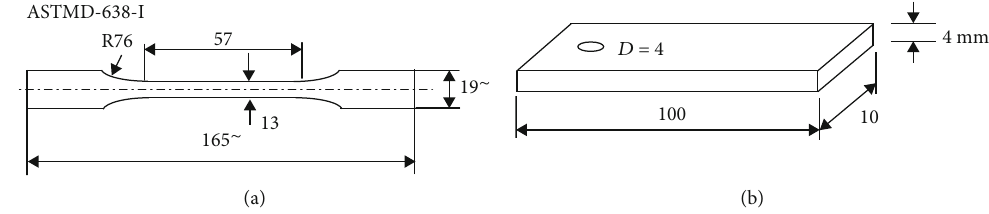
Figure 3: (a) The dimensions of the tensile specimen [24]. (b) The shape of the fatigue specimen [24].